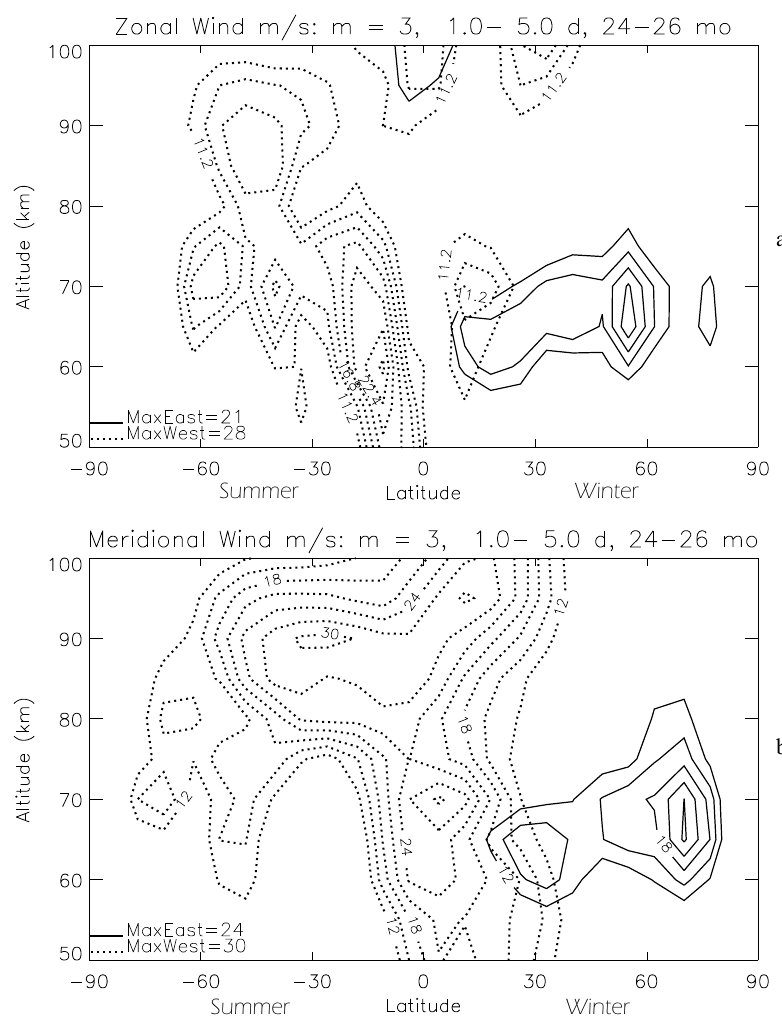
Fig. 11. Height variations of m=3 PWs with periods between 1 and 4 days, which bears on the results presented in Fig. 8. It shows the Rossby type PWs at mid latitudes, eastward in winter and westward in summer, and the westward propagating Rossby-gravity waves at low latitudes. Around 65km, the wave activity is concentrated in the winter hemisphere, but higher up the waves are more prevalent in the summer hemisphere, as Fig. 8 shows. In the zonal winds near the equator, the Kelvin wave signature appears above